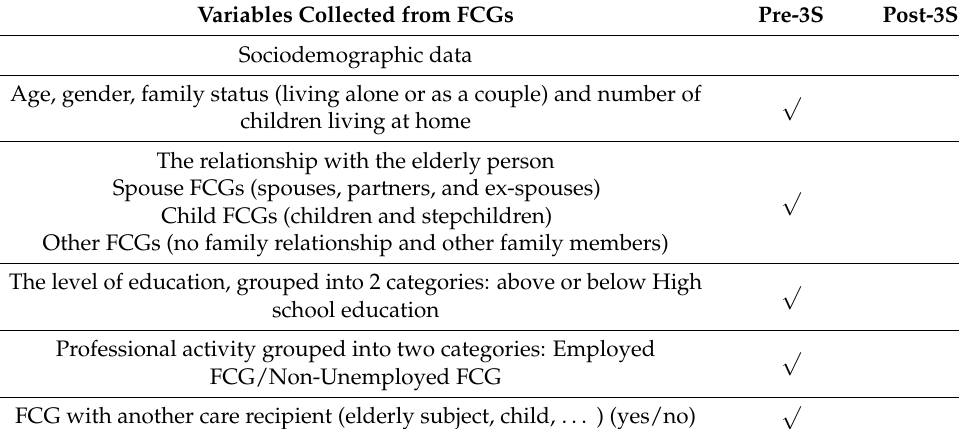
Table 1. Variables collected pre and post-3S. Variables Collected from FCGs Pre-3S Post-3S Sociodemographic